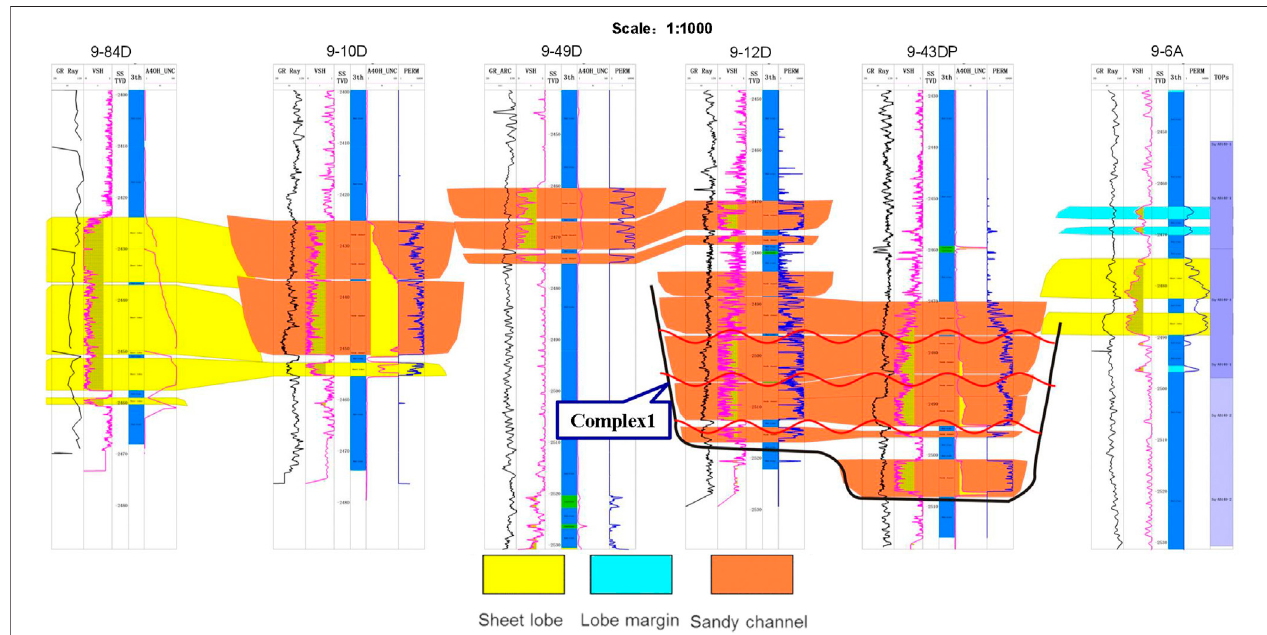
FIGURE 11 | Architecture boundary characteristics with lateral phase change in ABL oil fi